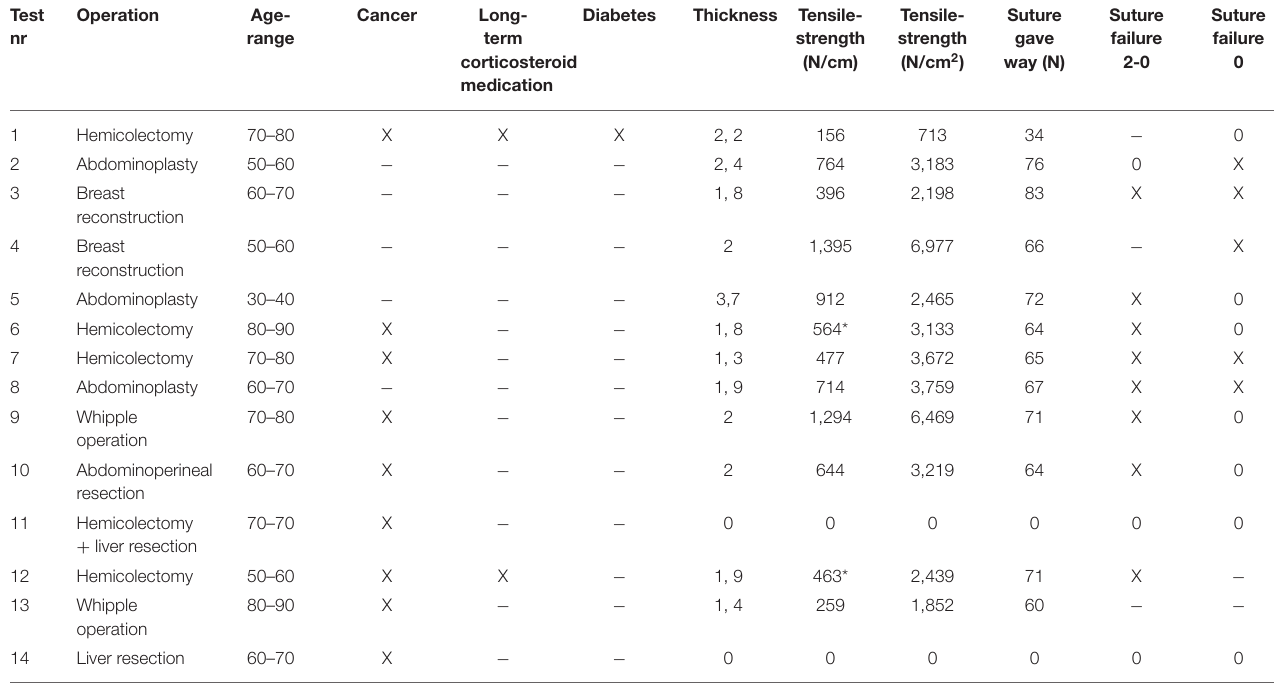
TABLE 1 | Patient characteristics and individual test results.